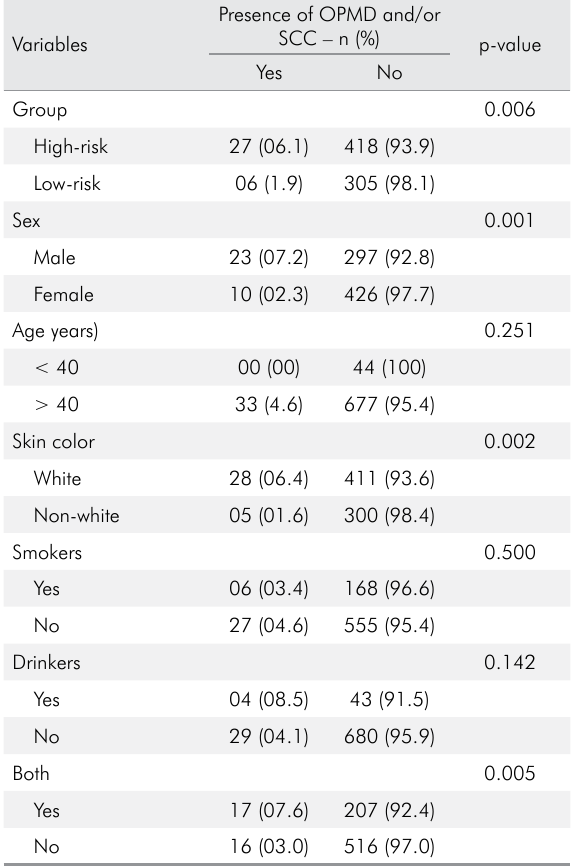
Table 3. Diseases diagnosed in the screening program, Piracicaba, Brazil, 2019–2021.